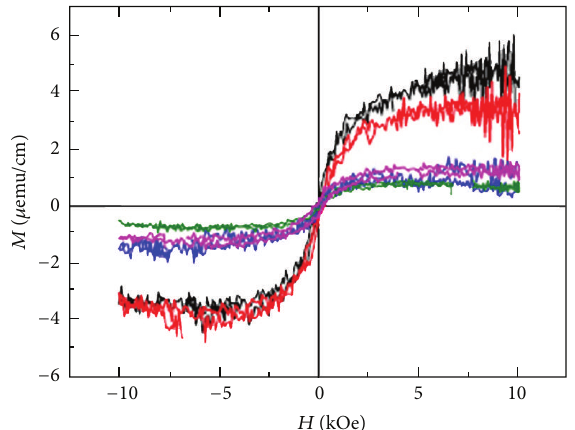
Figure 11: The disorder noises in 𝑀 - 𝐻 curves of nanoscale sample that are caused by utilization of diamagnetic substrate during measuring